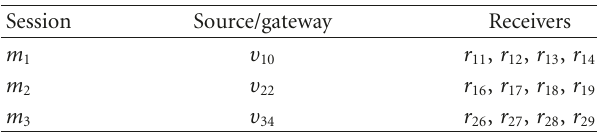
Table 2: Multicast tra ffi c pattern.